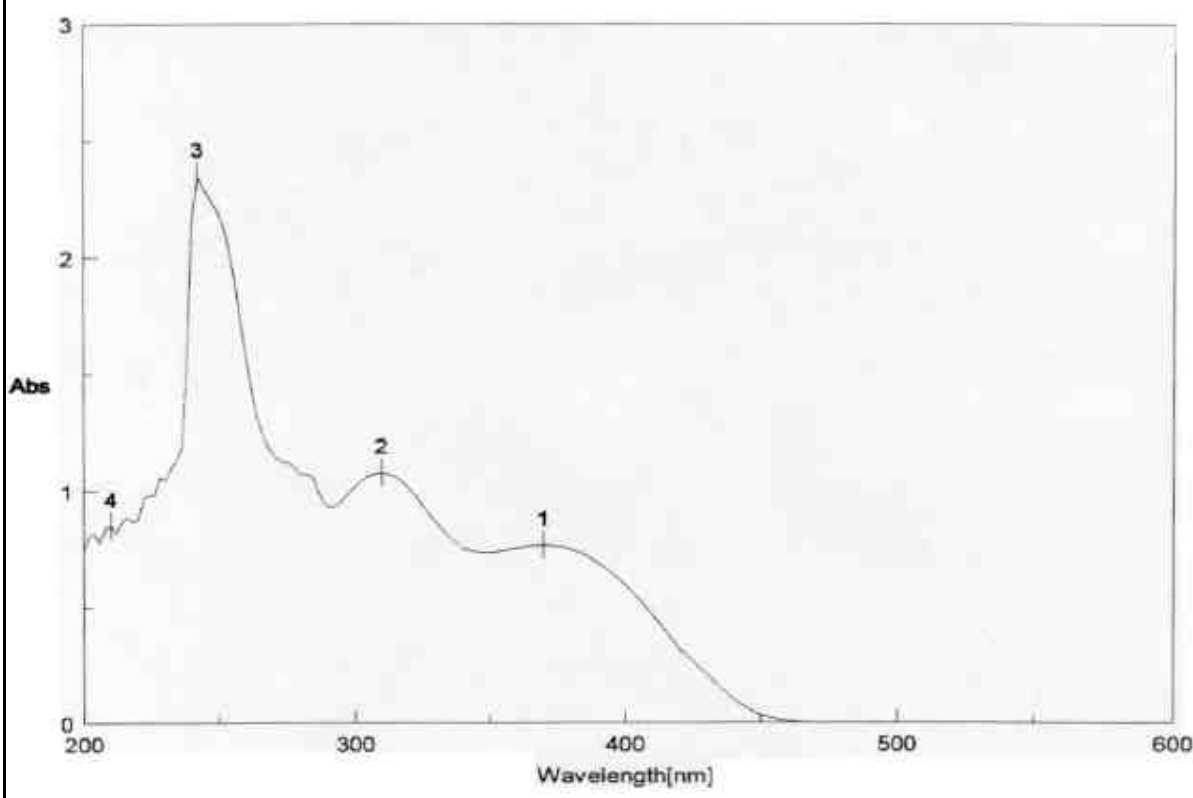
: 1: 370; 2: 310; 3: max